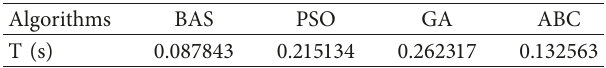
Table 2: Time comparisons of different algorithms in a two-di- mensional situation.